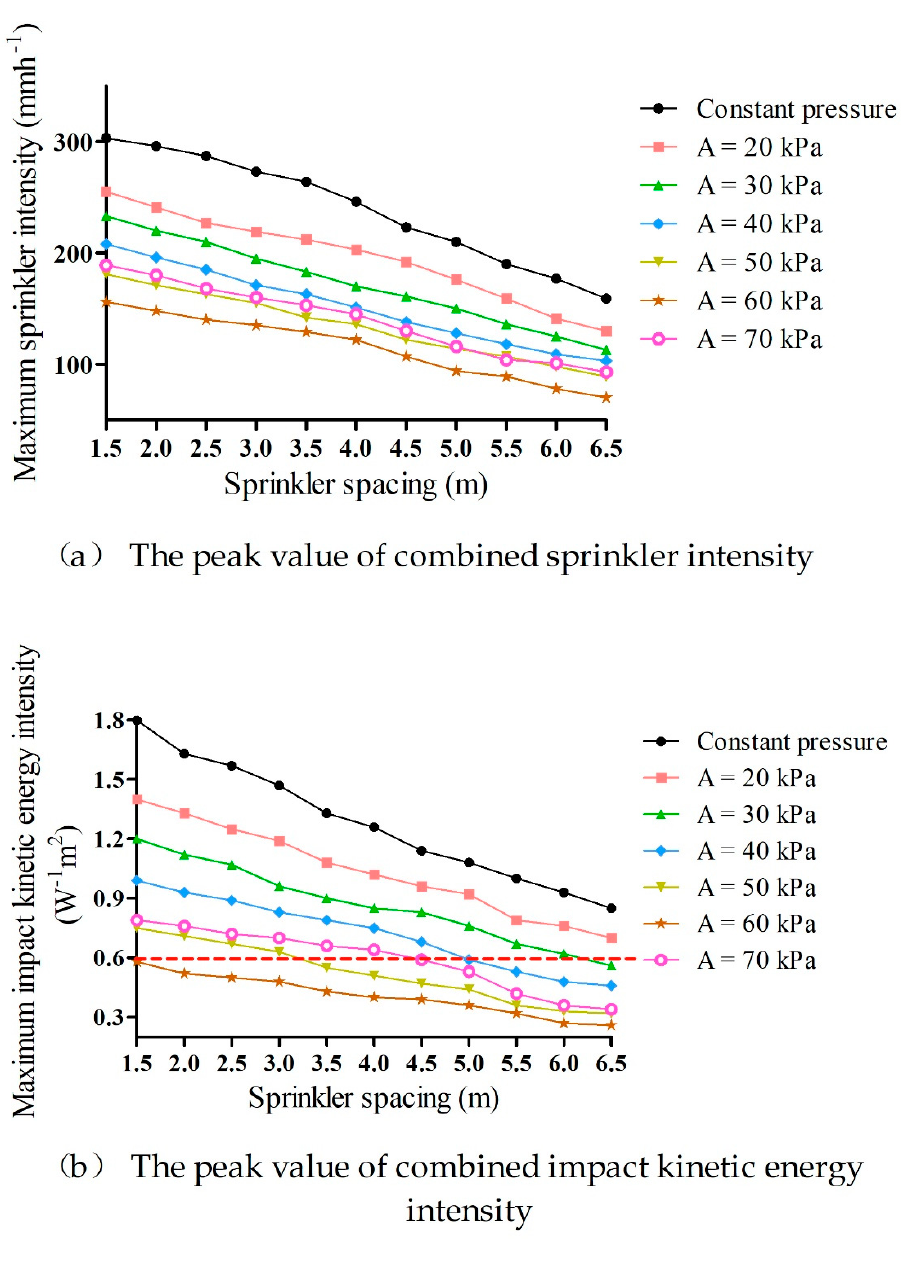
Figure 9. The peak value of combined sprinkler intensity ( a ) and impact kinetic energy intensity ( b ).